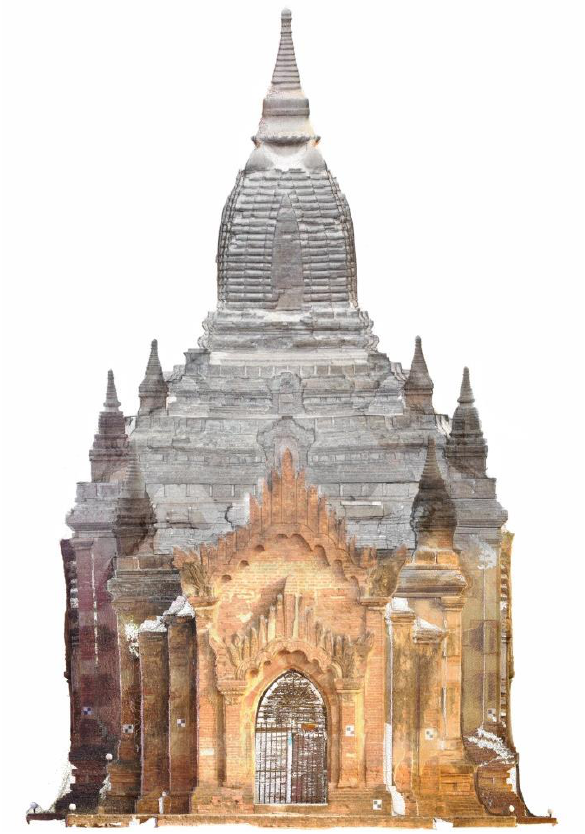
Figure 11 : Orthographic projection of the North Façade of the Loka- Hteik-Pan temple generated from the pointcloud. Two dimensional measured drawings have been developed from these orthophotos (Figure 12)’. These drawings were drawn at a scale of 1:50 and include enough detail to assess the condition and to analyse the physical structure of the temple. This approach was replicated for the successive drawings, including elevations, floorplans, cross sections, site plans and roof plans of the four recorded